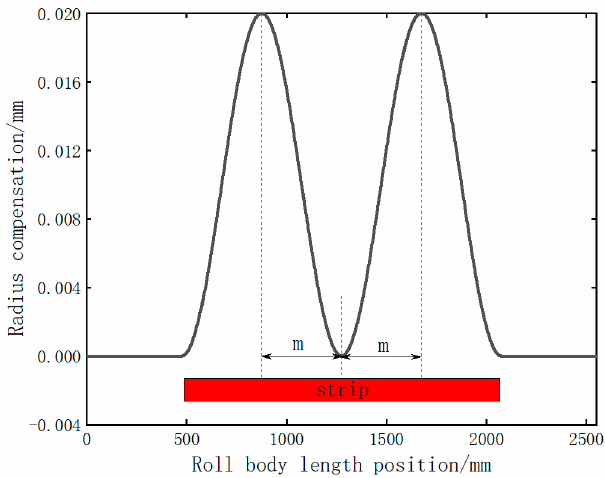
Figure 7. Compensation curve for superposition.